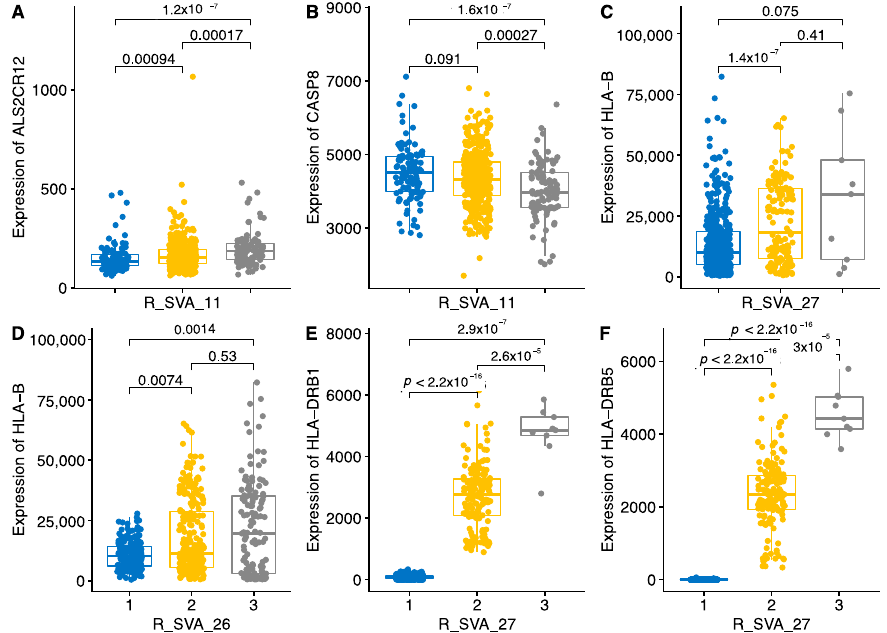
Figure 7. Boxplot of six different genes influenced by SVAs. Genotypes of SVAs are shown as number 1 for AA, 2 for PA and 3 for PP. Numbers and lines above the bar show p -values of the pairwise comparison. p -values are from the Wilcoxon pairwise comparison. Panels A-F indicate six genes and their expression dependence on the SVA genotype, Panel B shows dose-dependent downregulating effect of SVA-11. Int. J. Mol. Sci. 2021 , 22 , x FOR PEER REVIEW